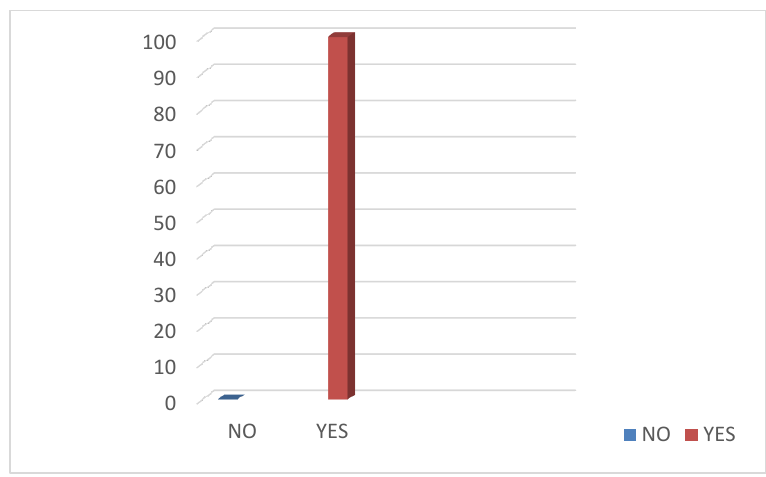
Fig. 2. Psychosocial therapy is an essential component of nursing care